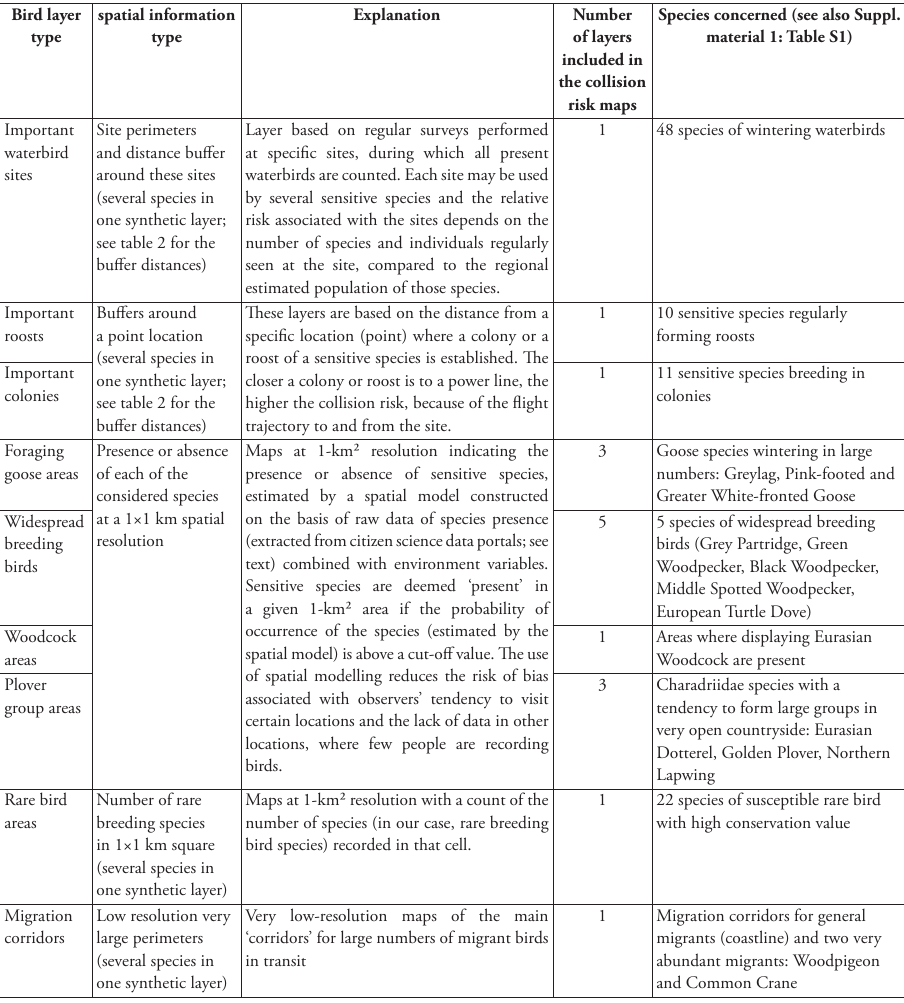
Table 1. Description of the spatial layers containing bird distribution or abundance information used in sensitivity